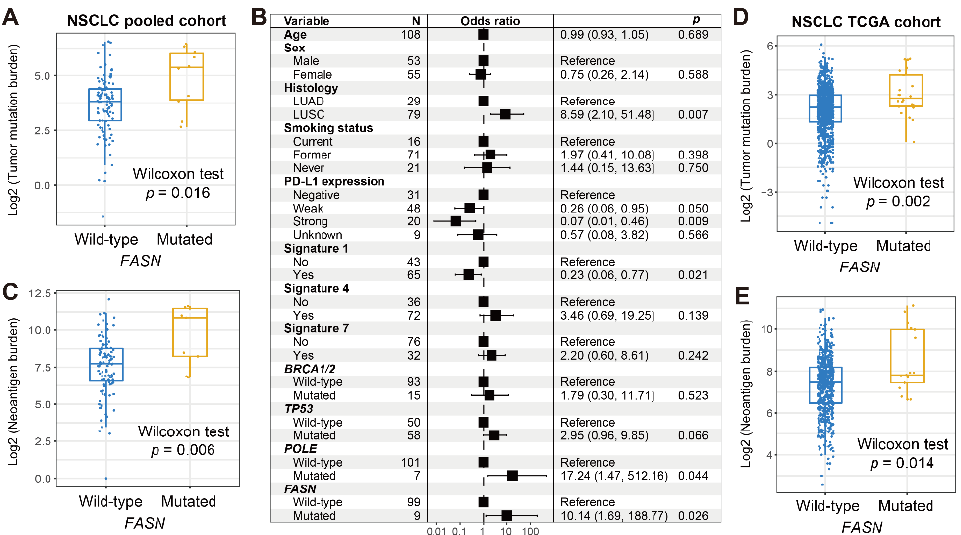
Figure 5. Association between FASN mutations and mutational burden in NSCLC. ( A ) Distinct distribution of TMB in FASN two subgroups in the pooled cohort. ( B ) Multivariate logistic regression model of FASN mutations was conducted with clinical factors, extracted mutational signatures, and genomic maintenance regulator mutations taken into account. ( C ) Distinct distribution of NB in FASN two subgroups. Association of FASN mutations with ( D ) TMB and ( E ) NB in the TCGA co ‐ hort.